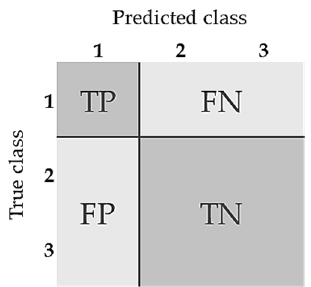
Figure 4. Confusion matrix of true (T), positive (P), false (F), and negative (N) labels for a dataset within a multiclass problem.